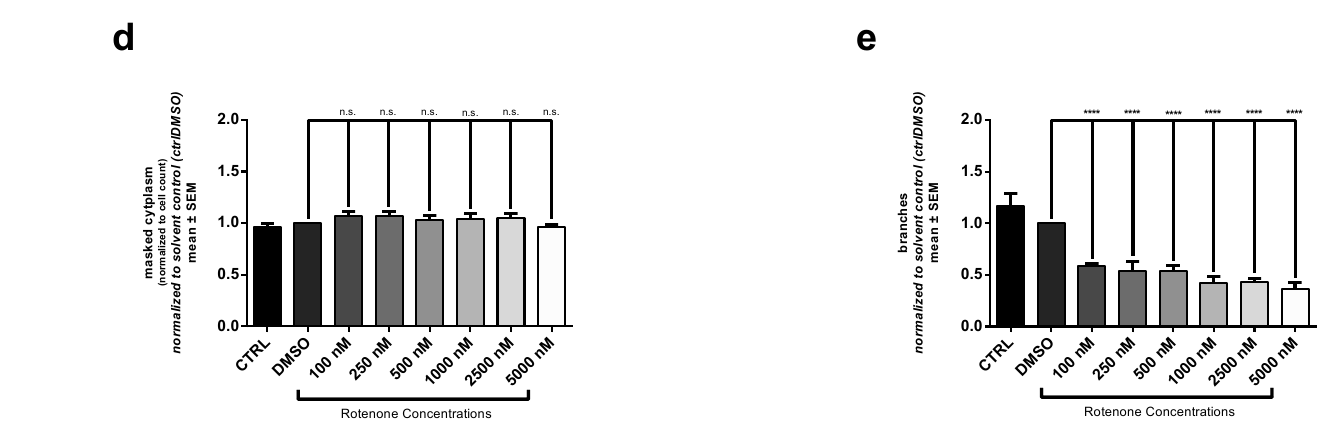
Figure 4. Additional morphological endpoints analyzed by our approach. ( a ) Linear regression performed on results automated and manual cell count. ( y = 0.9511 · x + 0.3678; R 2 = 0.9430) The following endpoints were quantified: ( b ) cell number, ( c ) nucleus area, ( d ) cell body area and ( e ) neurite arborization. For interpretation results from quantification of cell number and neurite arborization were normalized to solvent control (DMSO). Values of nucleus and cell body area were first normalized to cell count and afterwards normalized to solvent control (DMSO). Data are shown as mean ± SM. * Significantly different ( p < 0.05) between mean of solvent control (DMSO) and mean of according Rotenone treatment condition. Respectively ** with p < 0.01, *** with p < 0.001 and **** with p <